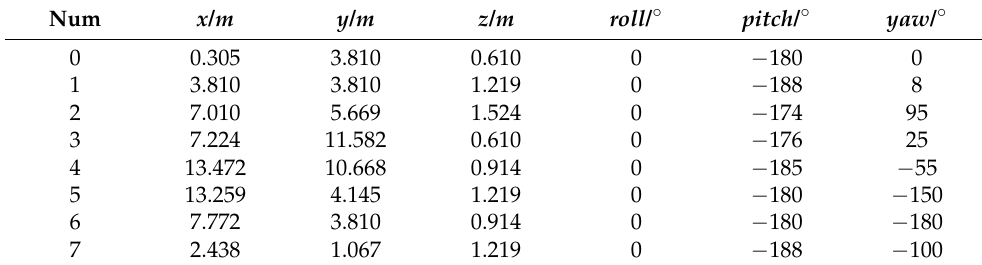
Table 2. IMU and lidar time offset calibration results. Num.